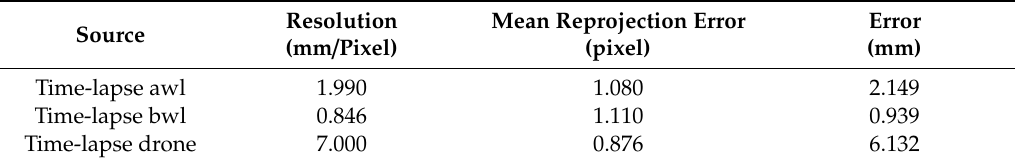
Table 7. Resolution and reprojection errors of the models using awl, bwl, and drone images, as reported by the Metashape processing reports.